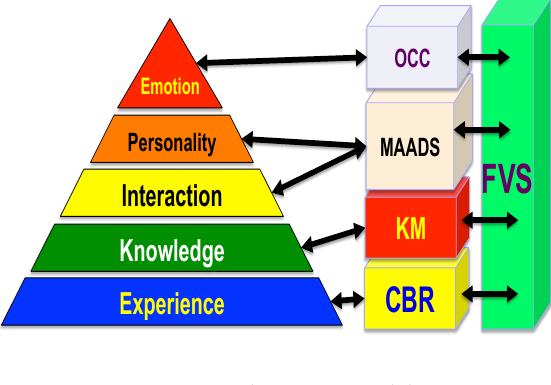
Figure 9. The EPICE